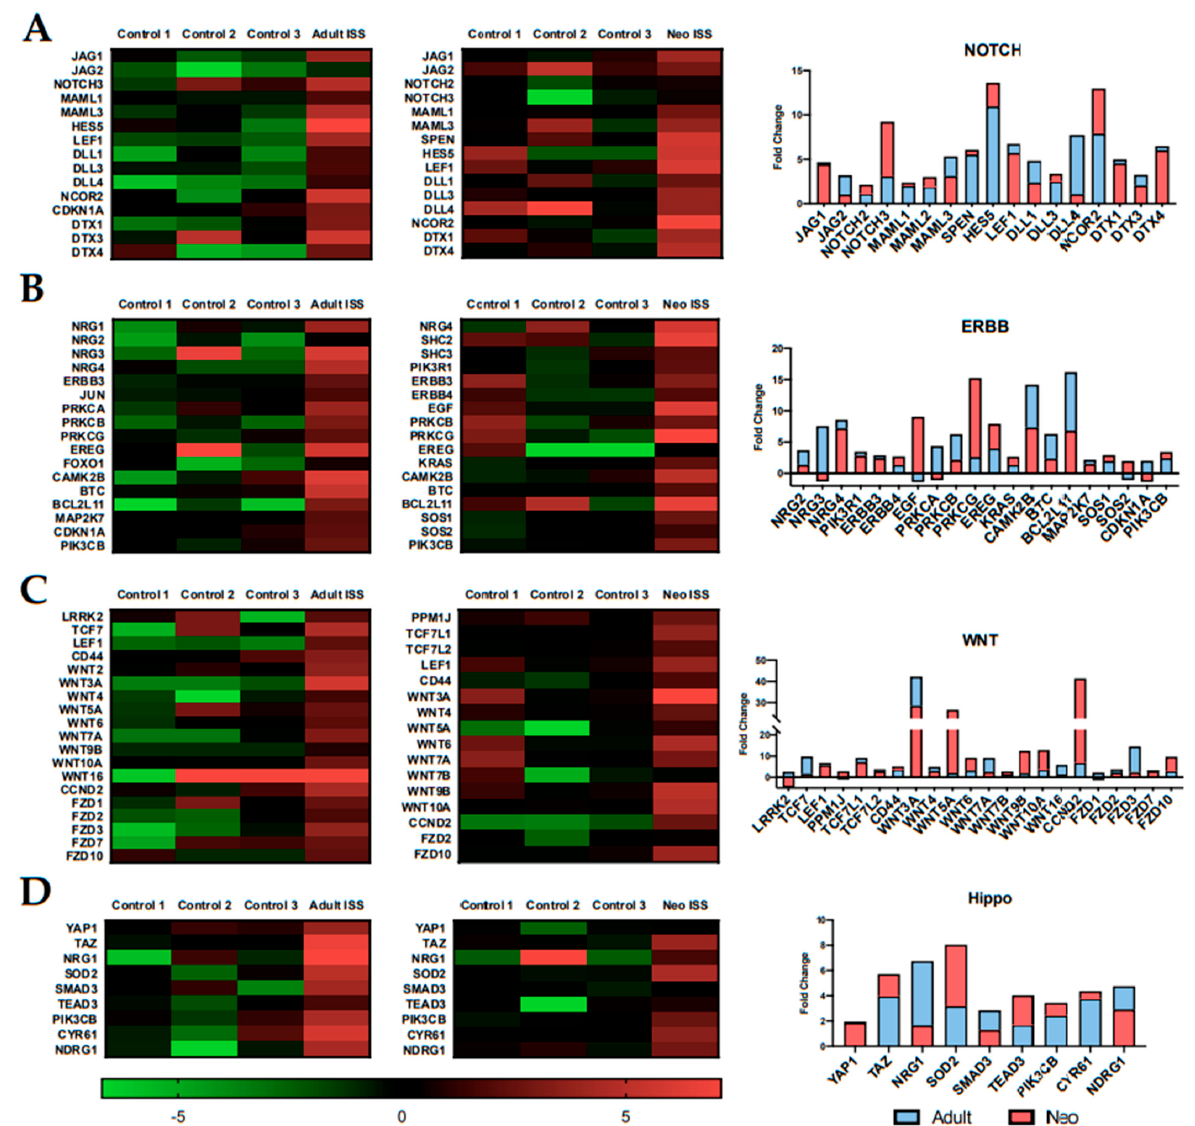
Figure 4. Pathways related to survival and proliferation were positively induced by spaceflight. Representative pathways include ( A ) Notch, ( B ) ERBB, ( C ) Wnt, and ( D )